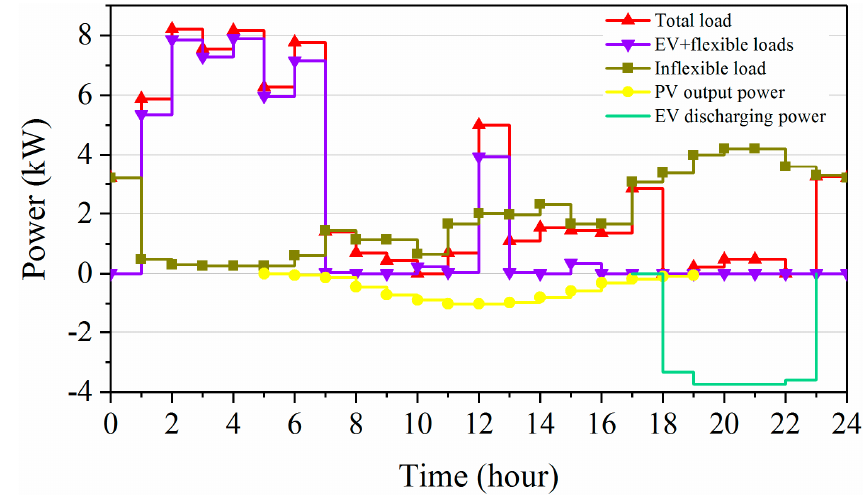
Figure 10. Optimized daily scheduling results for a typical household prosumer within RMG.